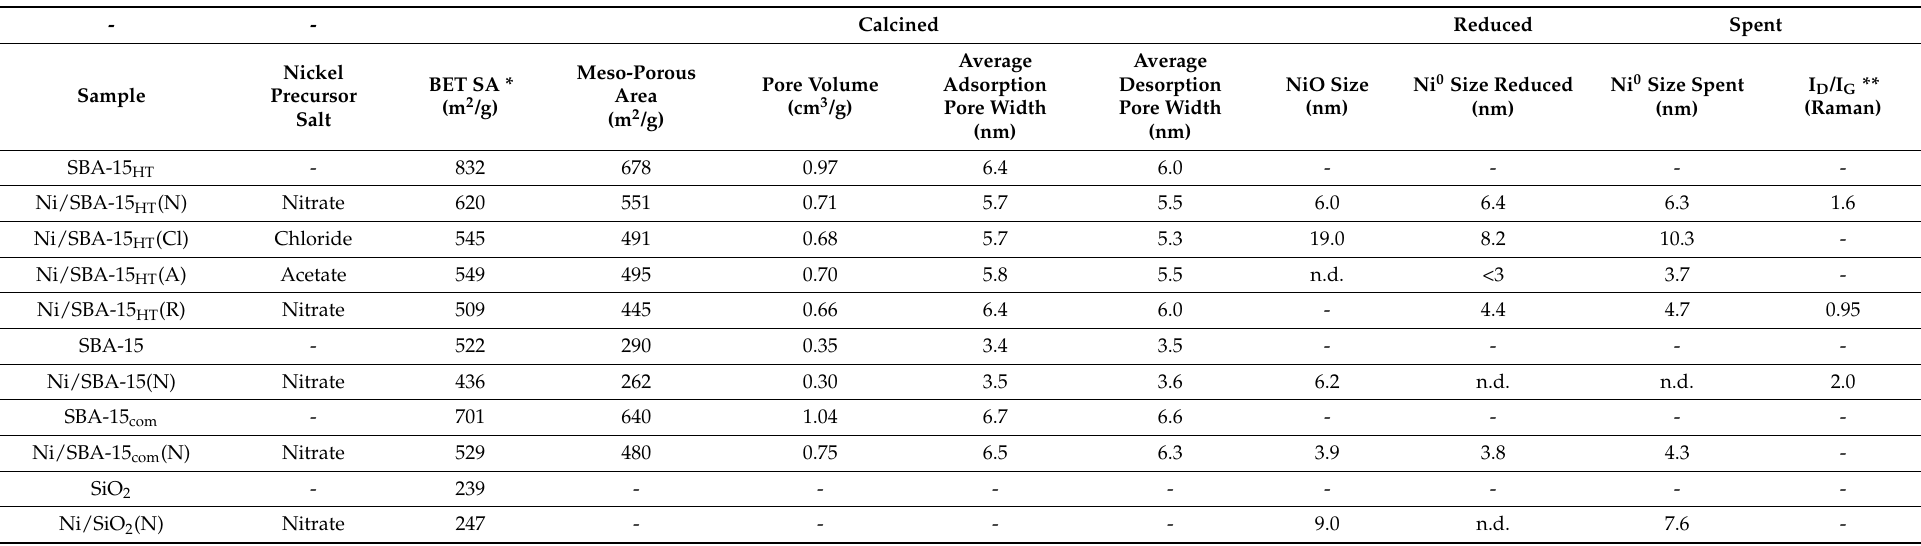
Table 1. Characteristics of the calcined, reduced, and spent